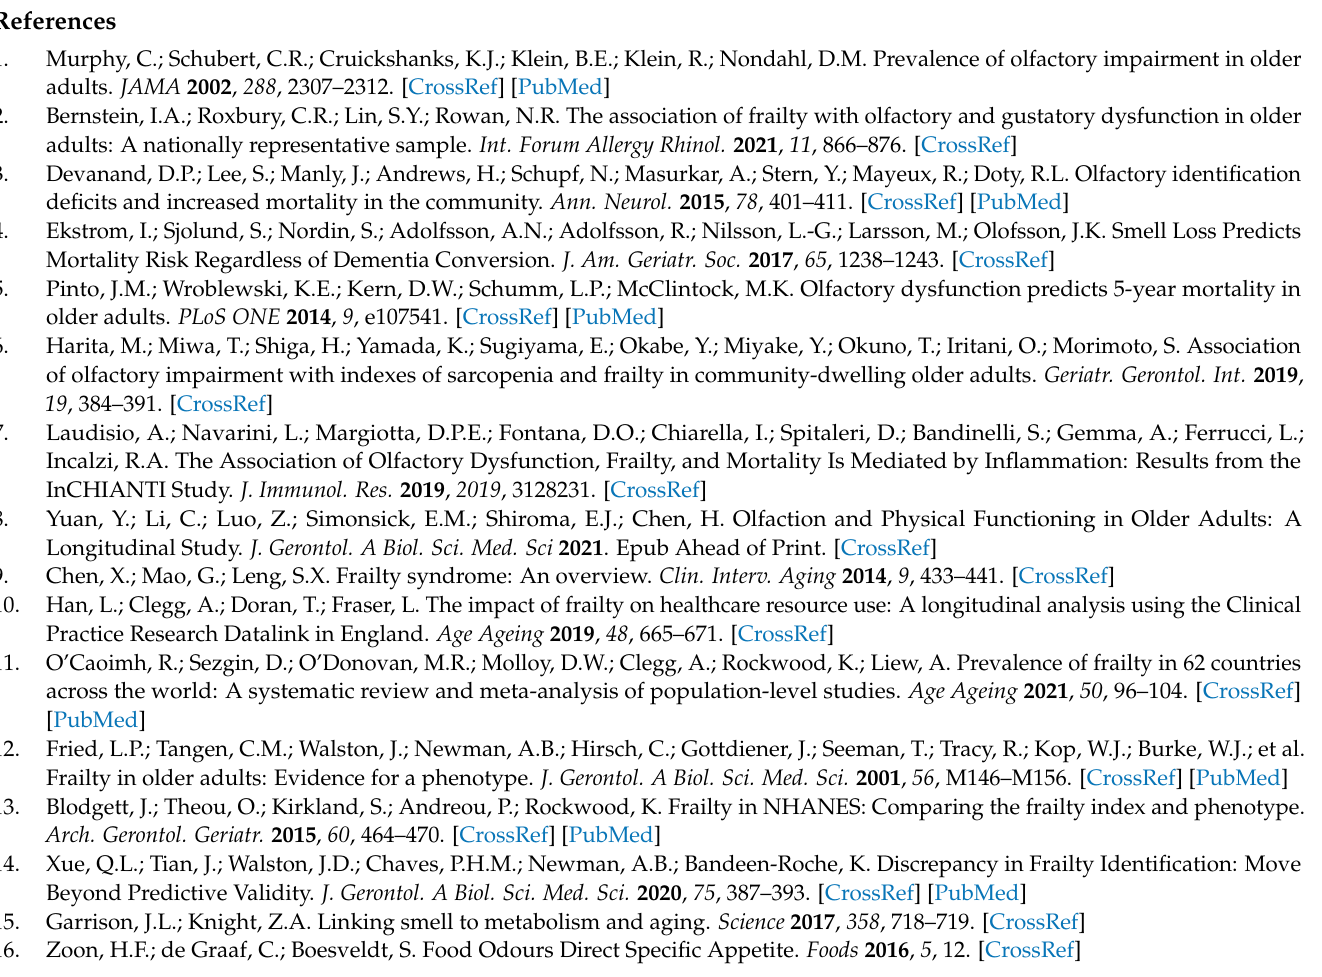
Table S5: Subgroup classified as frail by FI and robust by FP—demographics and health